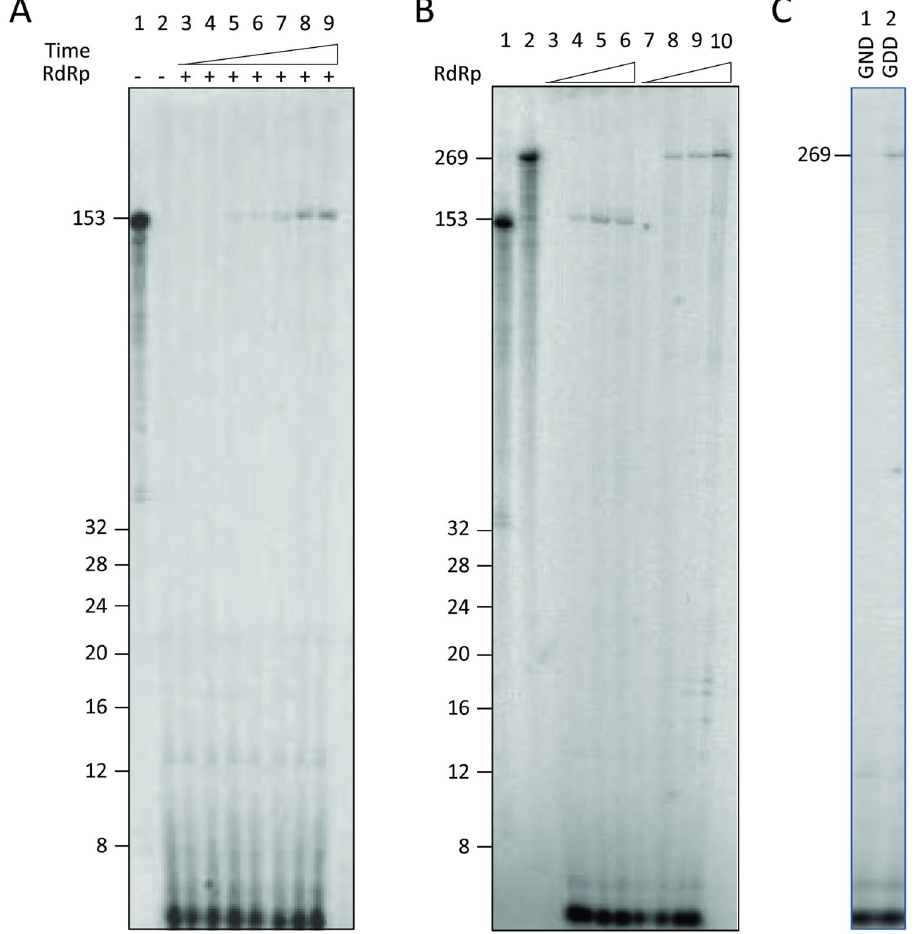
Figure 4. ZIKV RdRp enzymatic activities using natural templates. RNA substrates of 153 nucleotides and 269 nucleotides corresponding to the 3 ′ -end of the ( − ) strand were obtained by in vitro transcription in the presence of [ α 32 P]-UTP and subsequently used as molecular weight markers. Corresponding unlabeled RNAs were used as template to assay for the de novo RNA synthesis of the ZIKV RdRp as described in Material and Methods. ( A ) Time course experiment monitoring the ZIKV RdRp enzymatic activity (1.4 pmoles) using a 153–nucleotide long RNA as template. Lane 1: radiolabeled 153 nucleotides template. Lane 2: no enzyme. Lanes 3 to 9: reaction was pursued for 0, 5, 10, 15, 30, 60, 180 min, respectively. ( B ) Impact of the substrate length on WT RdRp activity. Lane 1 and 2: radiolabeled templates corresponding to 153 and 269 nucleotides, respectively. Lanes 3 to 6: synthesis using the 153-nucleotide long RNA substrate. Lanes 7 to 10: synthesis using the 269 nucleotides RNA substrate. Respectively 0, 0.7, 1.4, 3.5 pmoles of RdRp were used. ( C ) Lanes 1 and 2: Respectively, 1.4 pmoles of the GND mutant and WT RdRp (GDD) were used with the 269-nucleotide long RNA as template. Reactions were carried out for 2 h and products were separated on 12% polyacrylamide denaturing gels (7 M urea). Autoradiography was performed using an imaging plate (Fujifilm) and images were obtained with a FLA- 5000 Imaging System